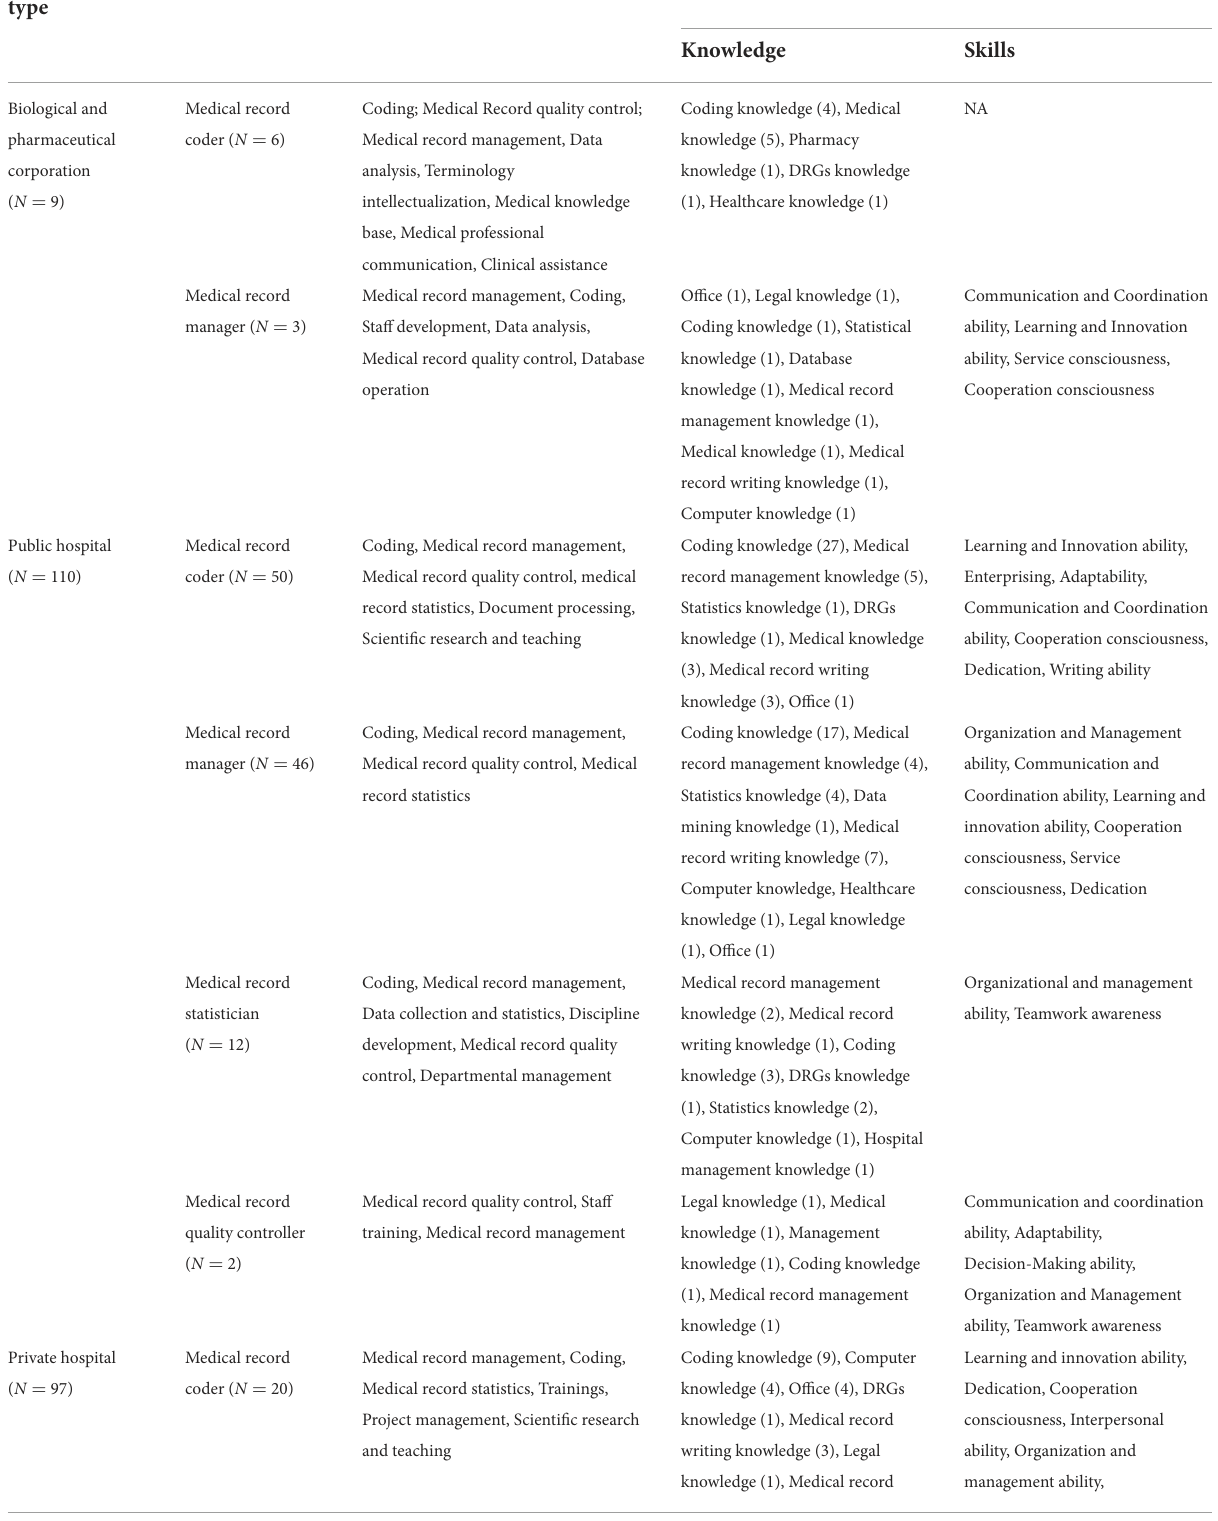
TABLE 4 Job analysis of typical positions (classification by different